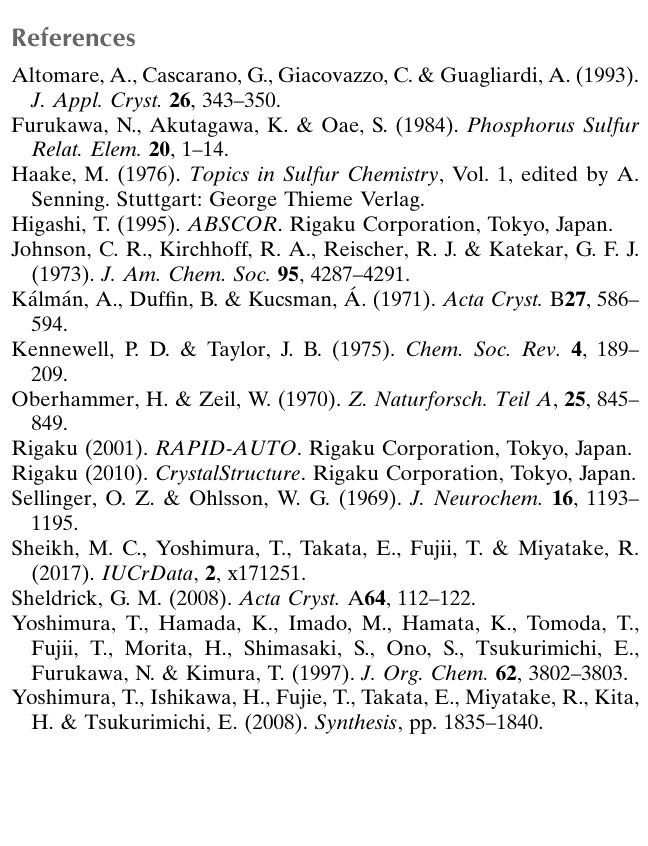
Table 2 Experimental details. Crystal data Chemical